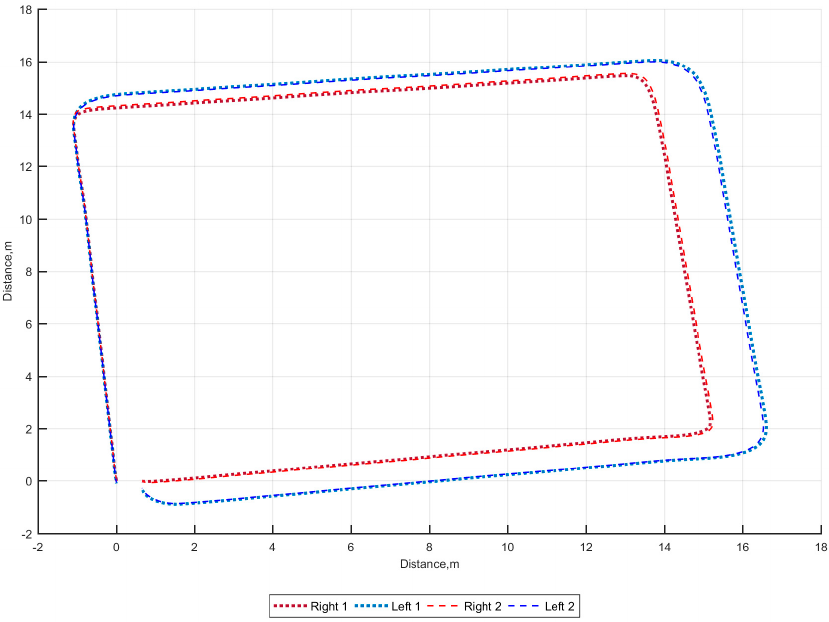
Figure 4. Trial 2, half court lap performed in a clockwise direction starting and finishing at the origin (0,0) with the error visually depicted by the incompleteness of the loop.